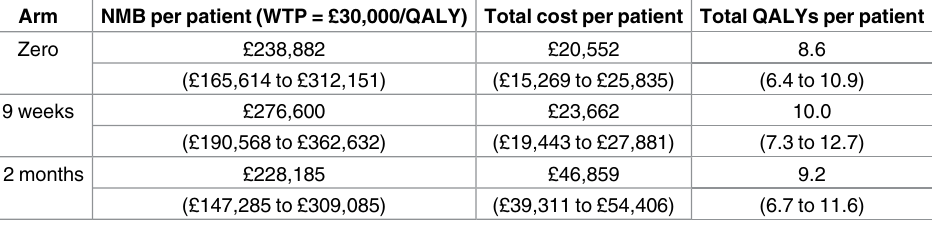
Table 4. Lifetime horizon probabilistic (n = 5,000) net monetary benefit per patient (WTP = £30,000/ QALY), total cost and total QALYs per patient per arm (mean and 95% CI of simulation